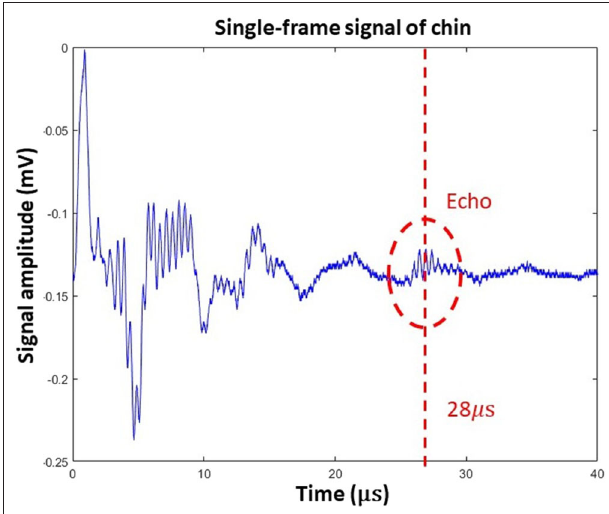
FIGURE 5 | A single A-line of human data acquired by a transducer placed under the chin.